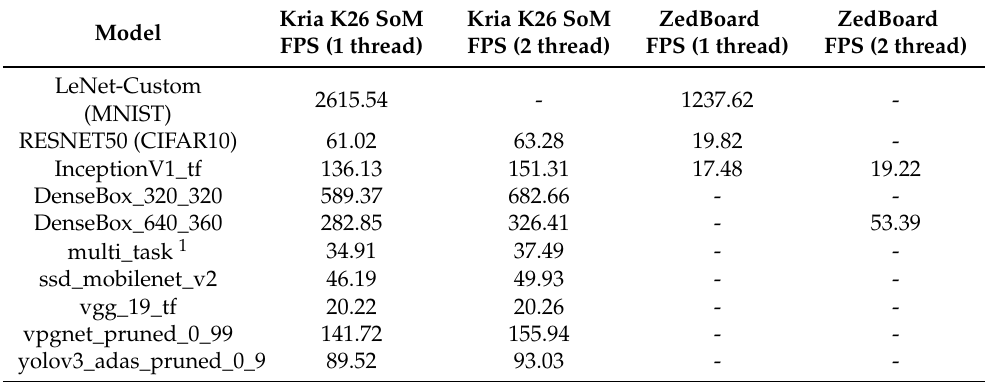
Table 1. Model inference performance on Xilinx K26 B3136 DPU & ZedBoard B1152